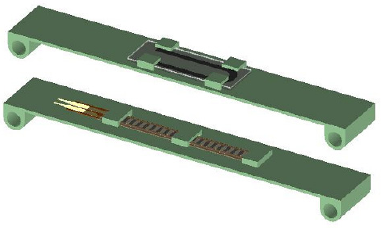
Figure 3. 3D representation of the lamina for the positioning of different sensors on the test bench.